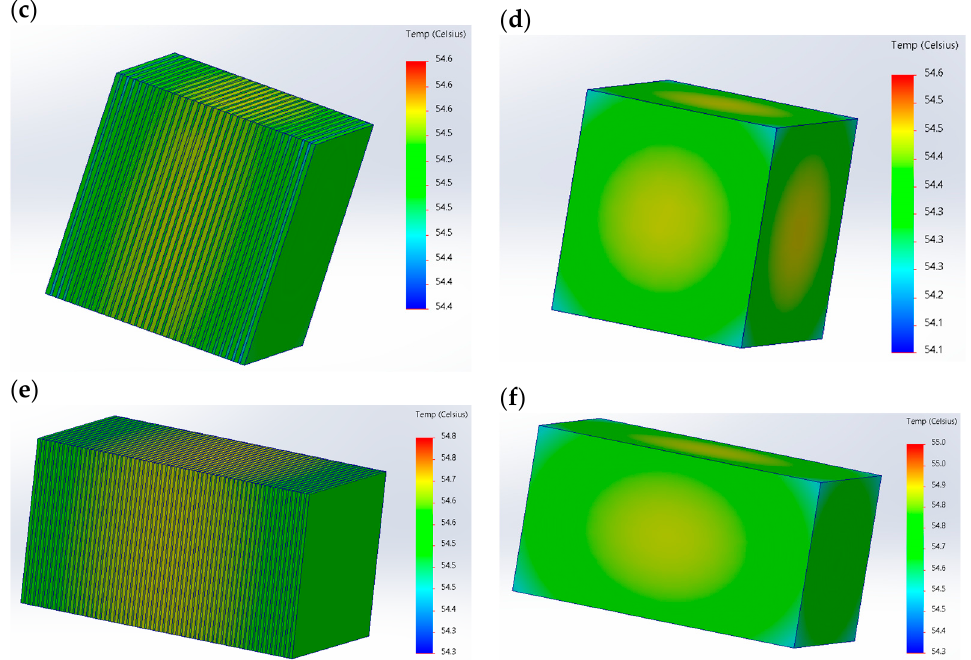
Figure 7. Model of temperature distribution in the inner cylinder of the capacitor ( a ) made of 15 layers of aluminum and polypropylene, ( b ) the model of a uniform material corresponding to 15 layers of aluminum and polypropylene, ( c ) made of 30 layers of aluminum and polypropylene, ( d ) the model of a uniform material corresponding to 30 layers of aluminum and polypropylene, ( e ) made of 60 layers of aluminum and polypropylene, and ( f ) the model made of uniform material corresponding to 60 layers of aluminum and polypropylene. The thickness of one layer of aluminum is 20 µm, and polypropylene is 10 µm.